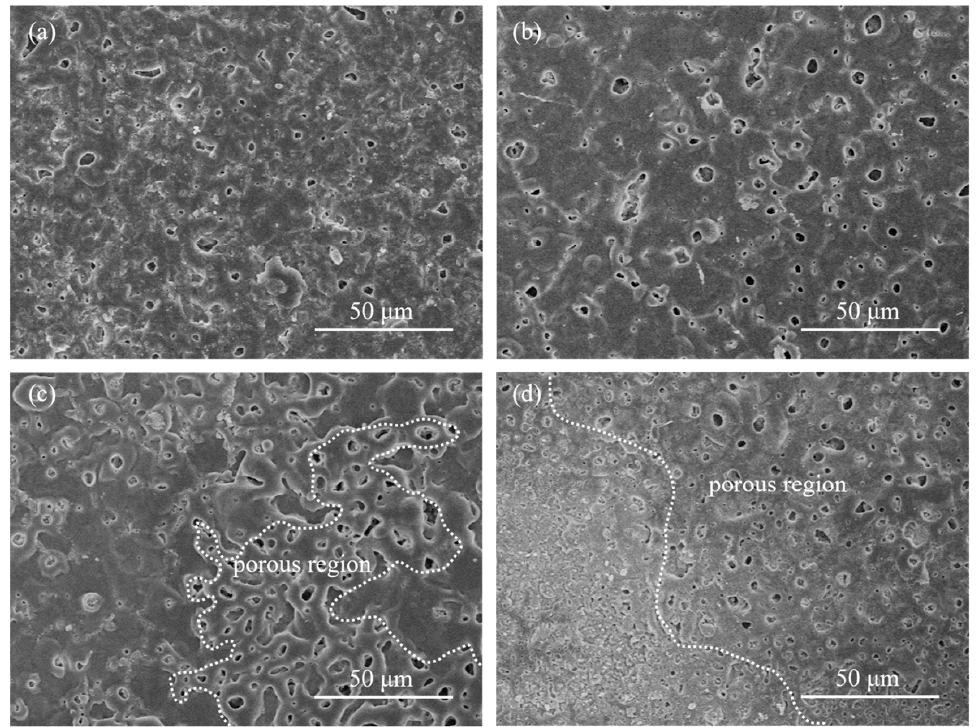
Figure 2. Surface morphology of the MAO film layers of different micro ‐ arc oxidized samples for 10 min: ( a ) Ti0 ‐ 15, ( b ) Ti5 ‐ 15, ( c ) Ti5 ‐ 25 and ( d ) Ti5 ‐ 35. The EDS results of surfaces of films Ti0 ‐ 15, Ti5 ‐ 15, Ti5 ‐ 25 and Ti5 ‐ 35 are shown in Table 2. Film Ti0 ‐ 15 without K 2 TiF 6 was mostly made up Al and O. The element composi ‐ tion of films Ti5 ‐ 15, Ti5 ‐ 25 and Ti5 ‐ 35 with the addition of 5 g/L K 2 TiF 6 all mainly con ‐ tained Al, O and Ti. With the addition of 5 g/L K 2 TiF 6 , the values of the Al mass percent decreased on Ti5 ‐ 15, Ti5 ‐ 25 and Ti5 ‐ 35 surfaces with the elevation of the electrolyte tem ‐ perature indicating a lower incorporation of Ti in the films [29]. However, the incorpora ‐ tion of the compositions from the solution increased with the elevation of the electrolyte temperature. The lower viscosity with the elevation of the electrolyte temperature led to